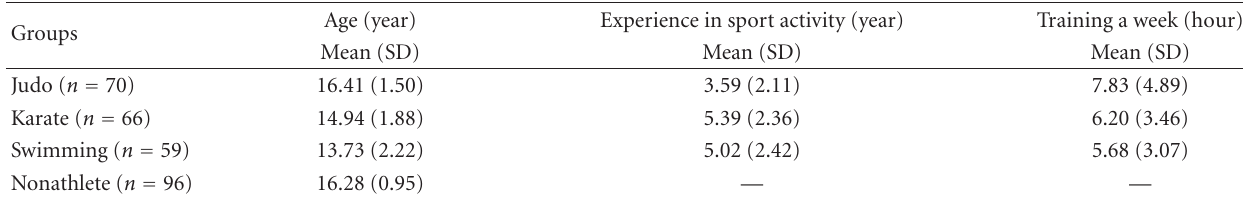
Table 1: Demographic information of participants by type of sport.